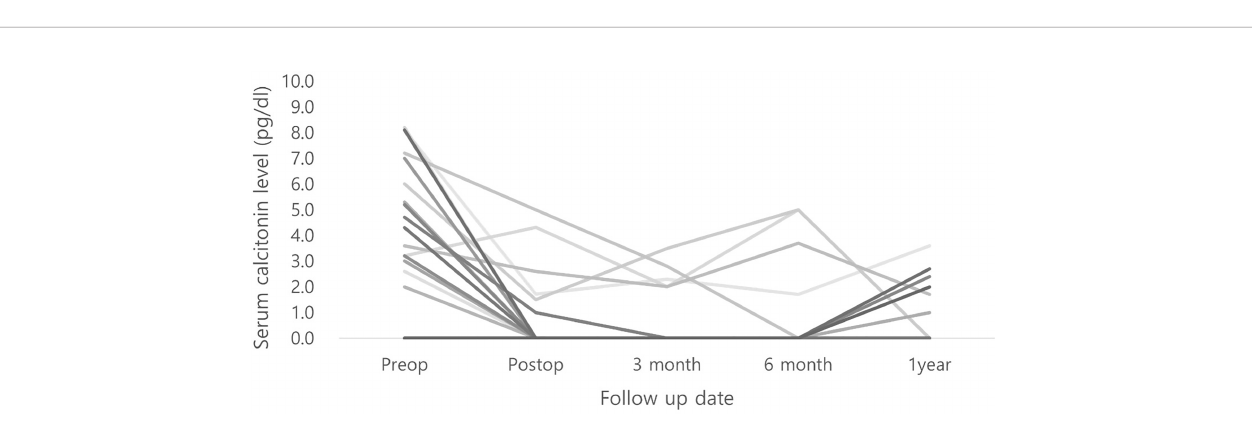
FIGURE 2 | Serum calcitonin levels of calcitonin-negative medullary thyroid carcinoma patients.